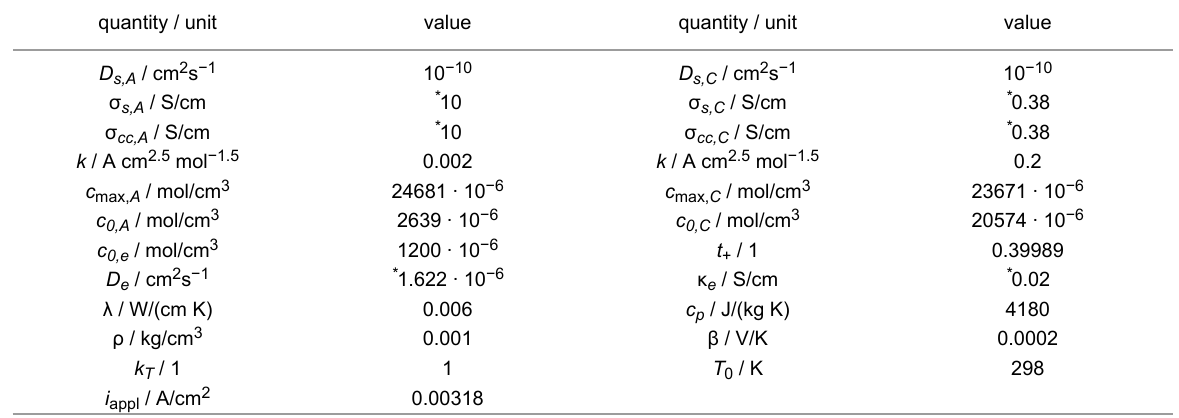
Table 1: Summary of generic parameter set used for the microscopic simulations. Subscripts s , e , cc , A , and C denote solid, electrolyte, current collector, anode, and cathode, respectively. For the thermal equation this study chooses identical parameters for all materials species. Quantities marked with an asterisk differ in the meso-simulations.